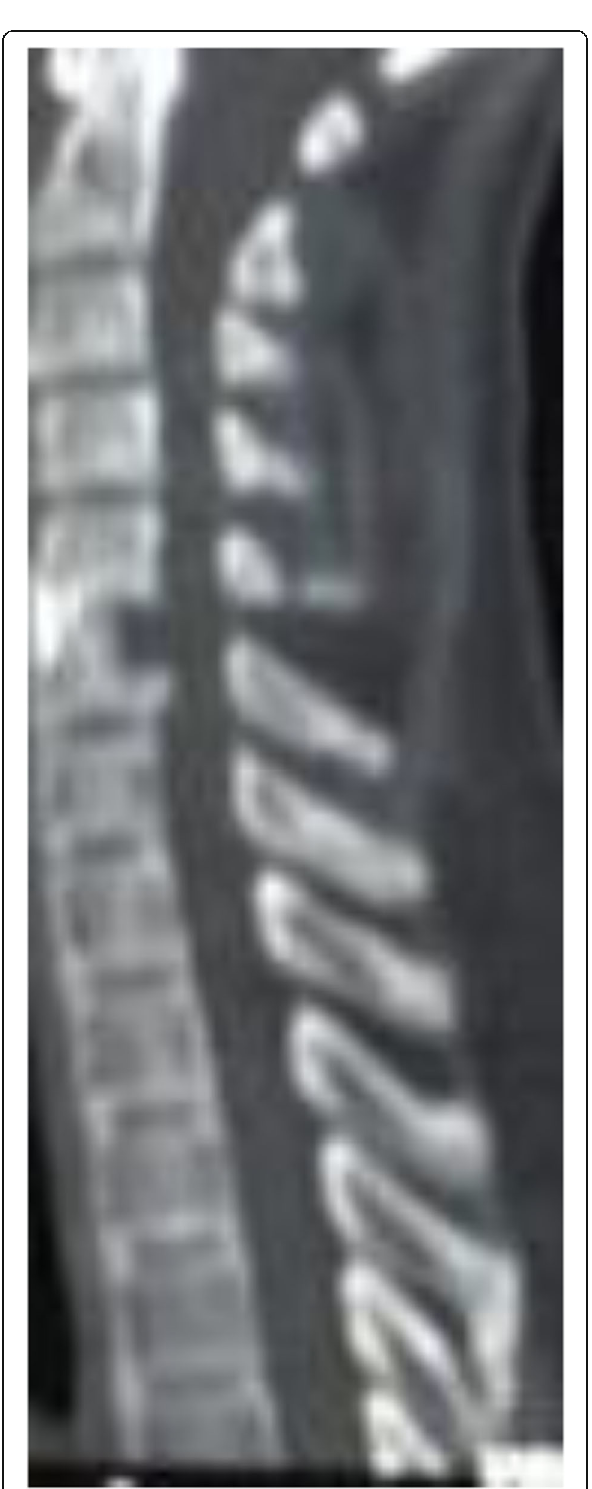
Fig. 8 C6 corpectomy, cage fusion, and plating